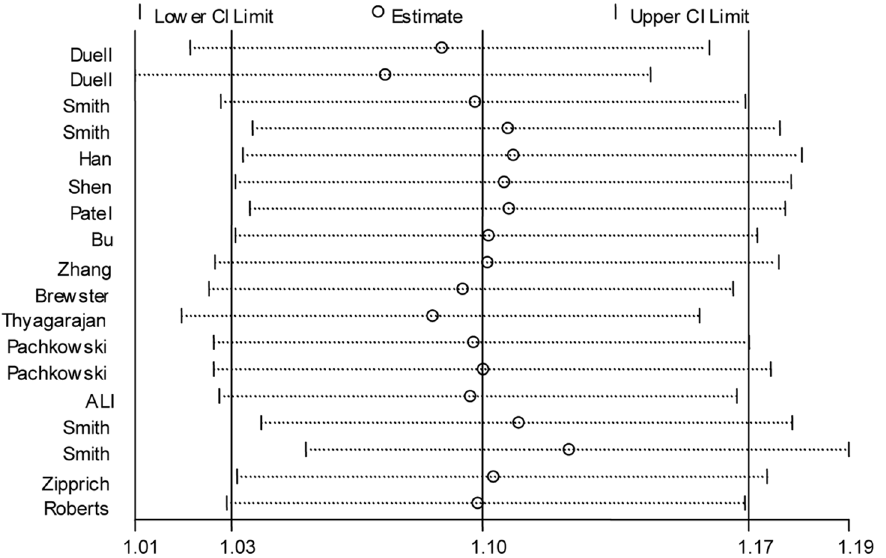
Figure 4. Sensitivity analysis of the association between the XRCC1 Arg399Gln and breast cancer risk for the dominant model.